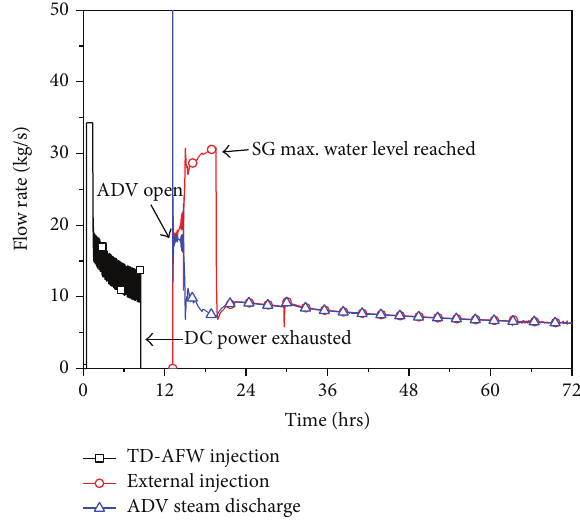
Figure 7: Secondary injection RCS and SG pressure.